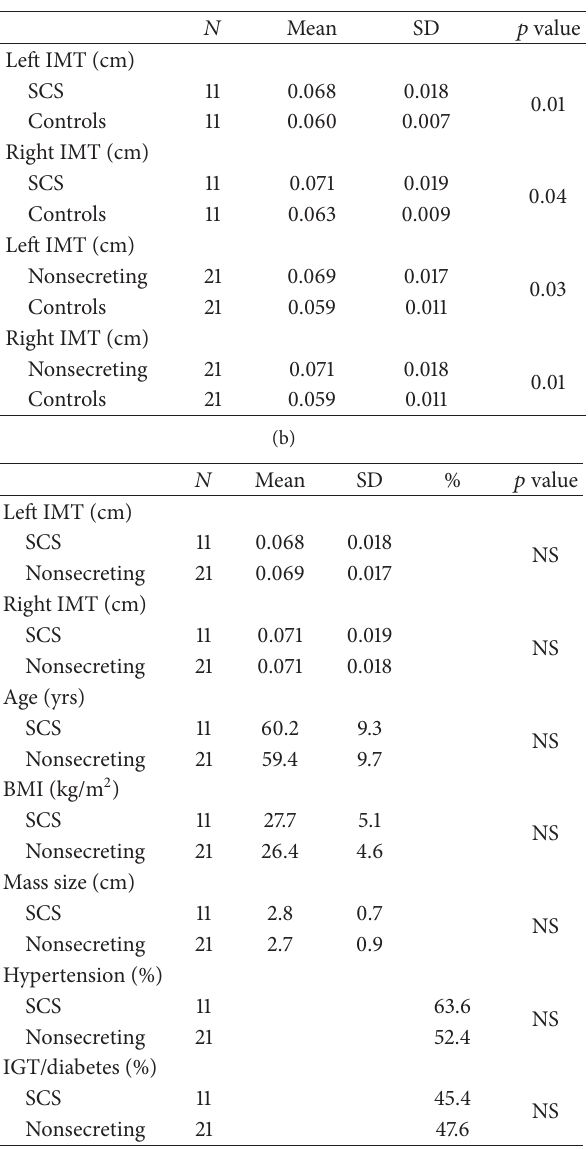
Table 3: Comparison of clinical parameters between patients with Comparison of IMT values between Group A and Group B with the matched controls